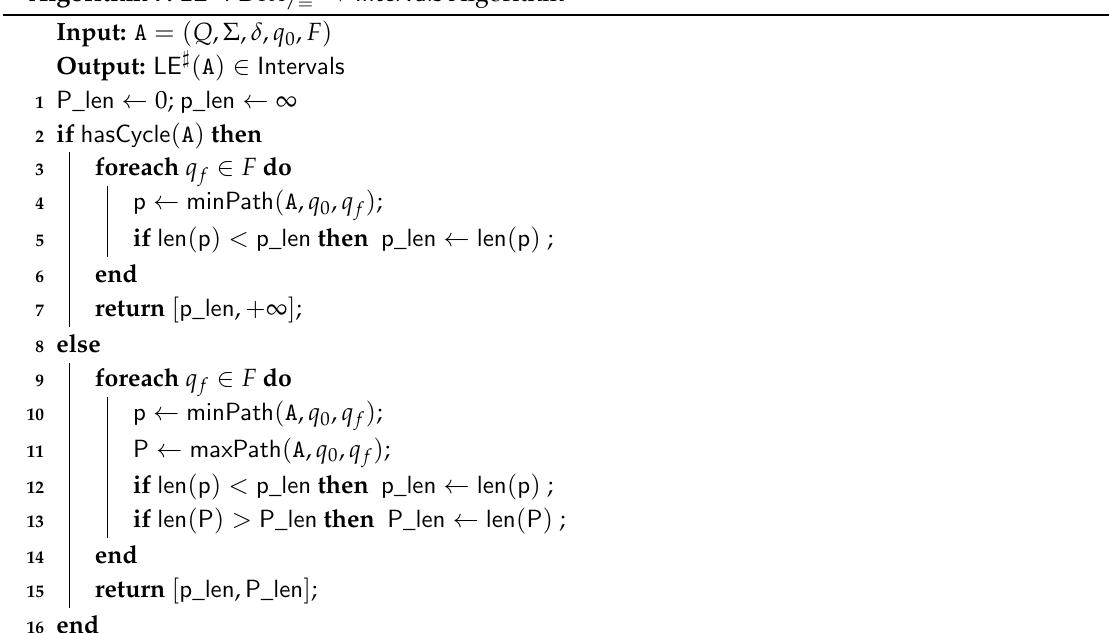
Algorithm 7: LE (cid:93) : D FA / ≡ → Intervals Algorithm